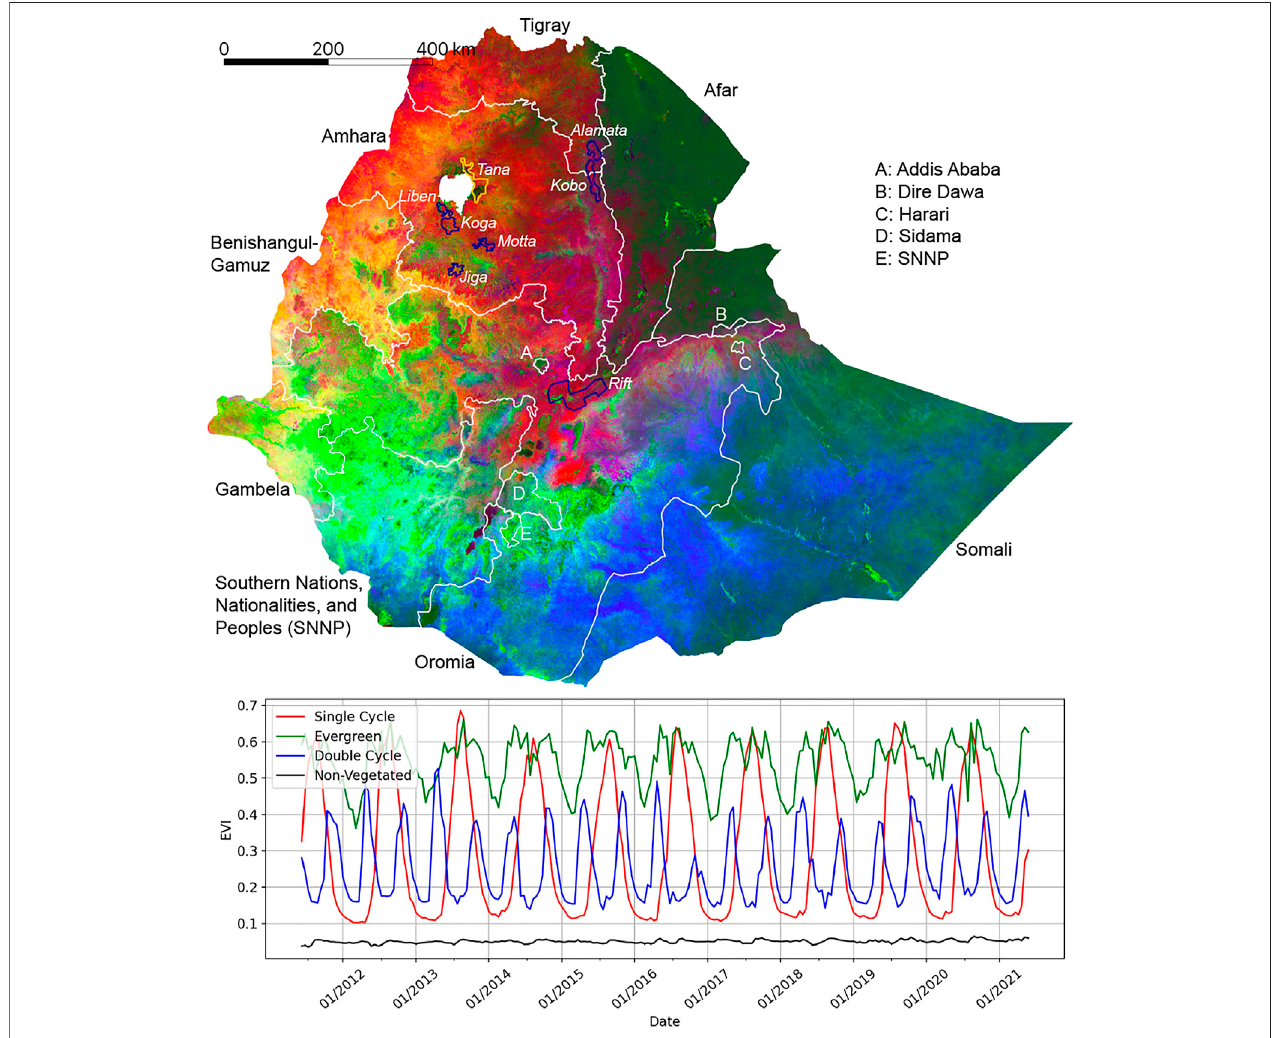
FIGURE 1 | Continuous endmember fraction map derived from a temporal mixture model of 250 m MODIS enhanced vegetation index (EVI) timeseries. Smooth gradientsandabrupttransitionsinphenologyareprimarilyrelatedtotopographyandvariationsinprecipitation.Regionnamesshowinglocationsoflabeledpolygonsare italicized: The region containing ground collection (GC) labels is delineated in gold; the regions containing visual collection (VC) labels are delineated in blue.